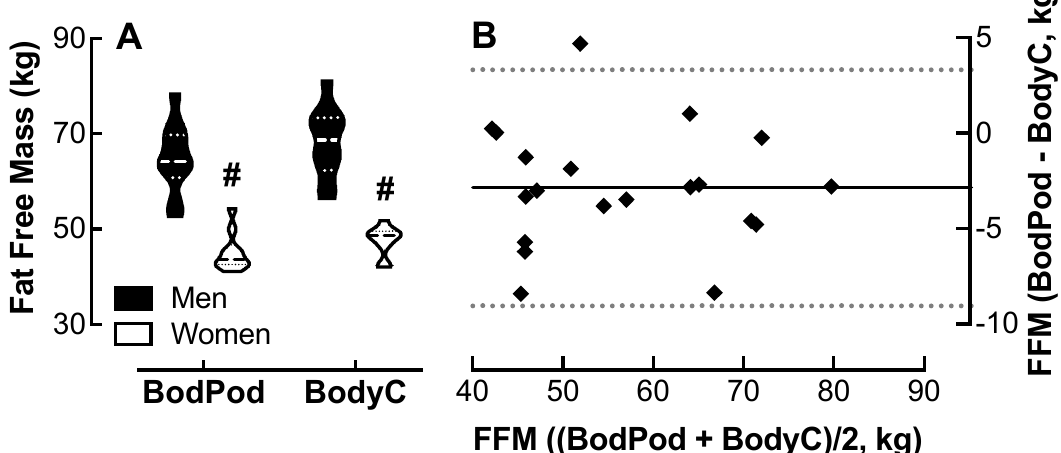
Figure 5. Comparison of fat free mass. (FFM) measured by the Body Cardio with Bod Pod determinations. ( A ) Violin plot of FFM measured by the Bod Pod and BodyC in men and women. p < 0.01, male vs. female by two-way ANOVA; n = 10/group. ( B ) Q-Q plot of FFM determined by the Bod Pod and BodyC. Each data point represents duplicate or triplicate measures in one study participant. FFM, fat free mass.